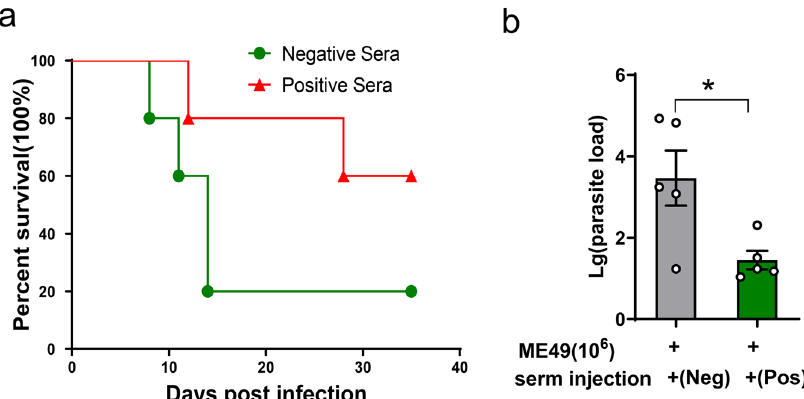
Fig. 8 Protective immunity with the sera of ME49 Δ cdpk3 -vaccinated mice against T. gondii infection. Passive immunization with serum from ME49 Δ cdpk3 -vaccinated mice reduced parasite reproduction in mice. BALB/c mice were challenge with 10 6 tachyzoites of ME49. At 0- and 3-day post-infection, the positive sera of ME49 Δ cdpk3 -vaccinated mice (125 days postvaccination) was injected into infected mice by tail intravenous ( n = 10 each group). Parasite burdens in peritoneal fl uids at 7 dpi were estimated by quantitative PCR. a Survival rates of mice. b Parasite burdens. The statistical analysis was performed by using unpaired t test. Bars = mean ± SEM. Statistical differences are represented by * p <